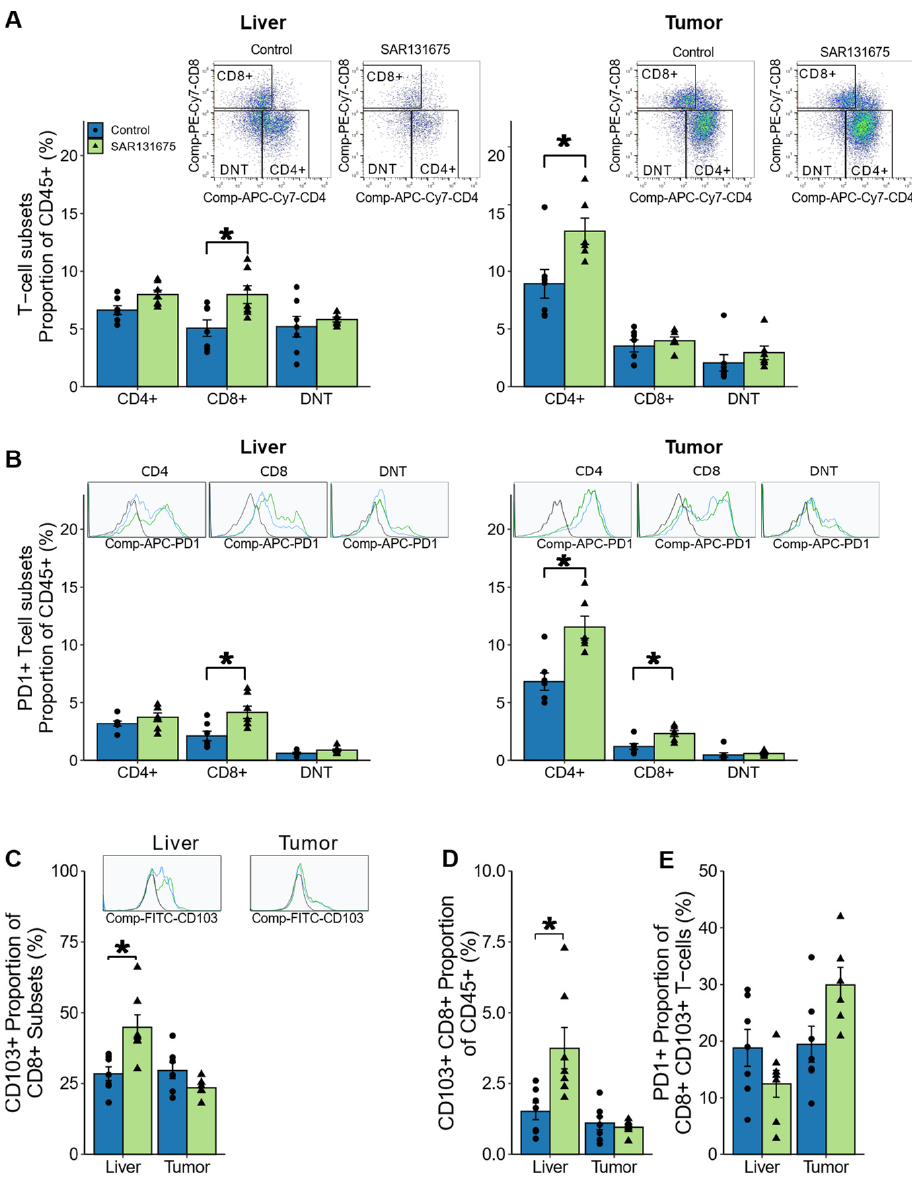
Figure 7. SAR131675 treatment alters T cells in liver and tumor at day 22. At day 22 CD3 + T cells were analyzed by flowcytometry for CD4 + , CD8 + and double negative (CD4 − CD8 − ) subsets. ( A ) Representative dot plots of CD45 + CD3 + T cell subsets in liver and tumor and percentage of T cell subsets as a proportion of CD45 + leukocytes. ( B ) Representative histograms of PD1 florescence within the T cell subset and percentage PD1 + T cell subsets as a proportion of CD45 + leukocytes in liver and tumor. ( C ) Representative histograms of CD103 fluorescence for CD8 + T cells and percentage of CD103 + as a proportion of CD8 + T cells. ( D ) Percentage of CD103 + CD8 + T cells as a proportion of CD45 + leukocytes and ( E ) percentage of PD1 + cells as a proportion of CD103 + CD8 + T cells in liver and tumor. Significance is indicated by * while non-significance is unmarked (* p < 0.05).